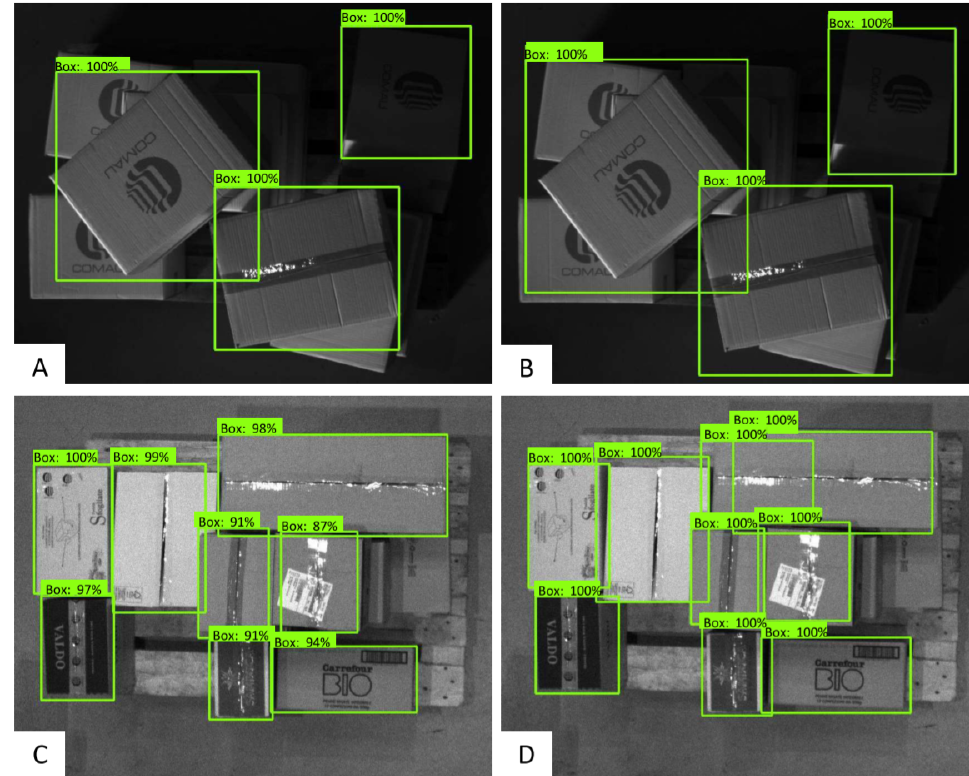
Figure 6. ( A ) Sample result of the model fine-tuned on Dataset 1 with a median F1-score of 94.7%. ( B ) Sample result of the model fine-tuned on Dataset 1 with a median F1-score of 90.9%. ( C ) Sample result of the model fine-tuned on Dataset 2 with a median F1-score of 83.9%. ( D ) Sample result of the model fine-tuned on Dataset 2 with a median F1-score of